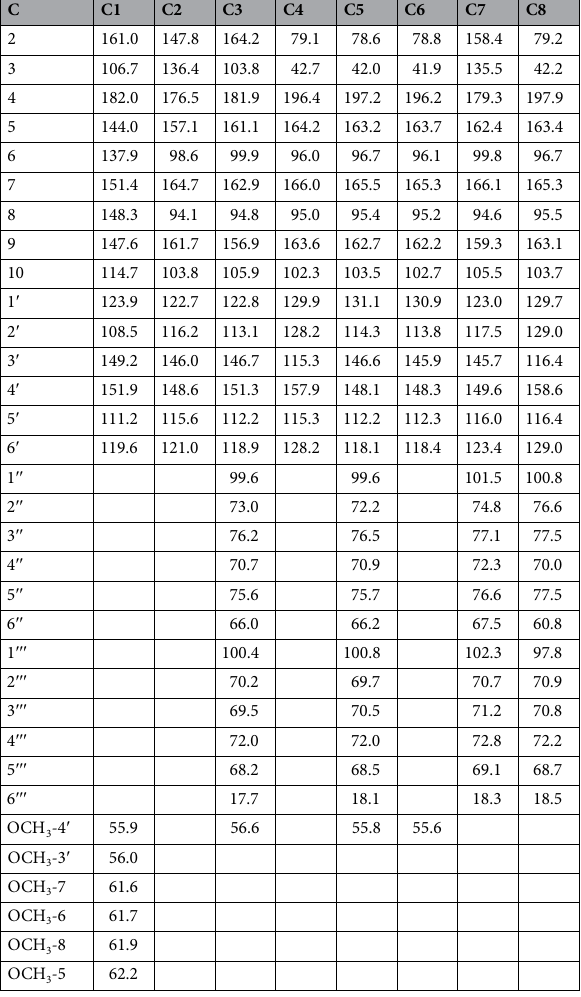
Table 2. 13 C NMR chemical shifts (δ ppm) for compounds C1 - C8 (DMSO, 100